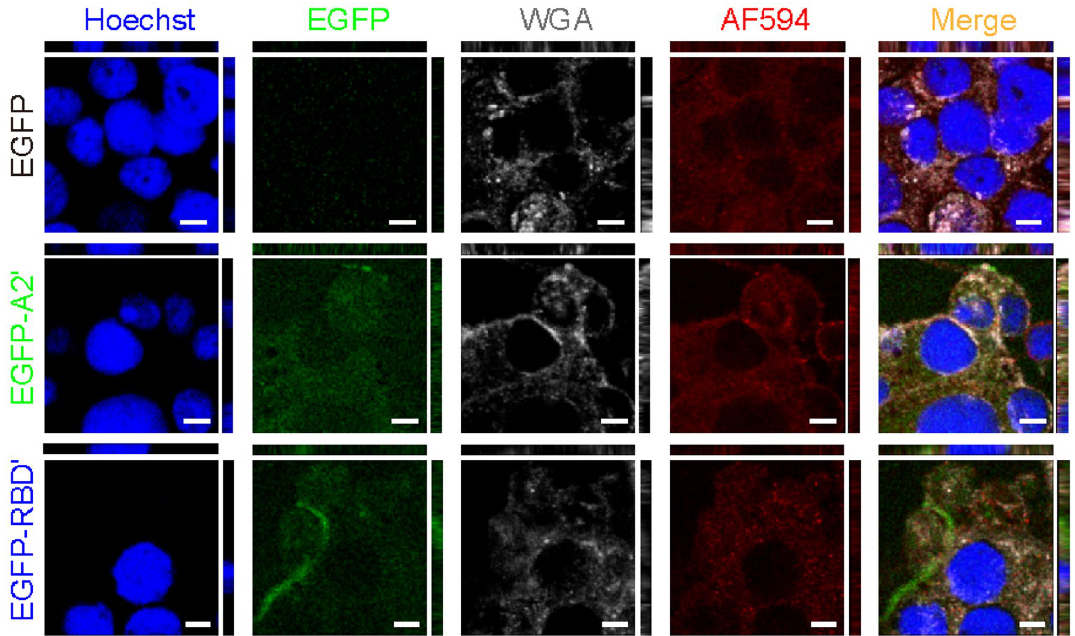
Figure 4. Orthogonal-viewed images obtained using confocal laser fluorescence microscopy. Differentiated PC-12 cells incubated with culture media containing the recombinant peptides (EGFP, EGFP-A2 ʹ , and EGFP- RBD ʹ ) for 1 min (scale bars, 5 μm). Nuclei, EGFP, glycolipids/glycoproteins, and late endosomes in the cells are in blue (Hoechst, Hoechst 33258), green (EGFP), gray (WGA, wheat germ agglutinin Alexa Fluor 647 conjugate), and red (AF594, Alexa Fluor 594), respectively. Images at the bottom-left, top-left, and bottom-right in each image are the upper, y-axis, and x-axis views,